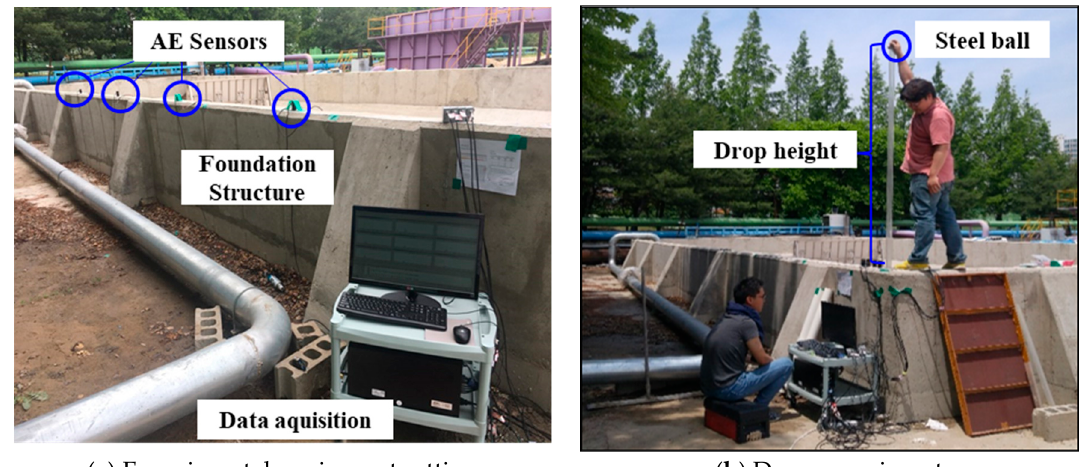
Figure 5. Experiment process.